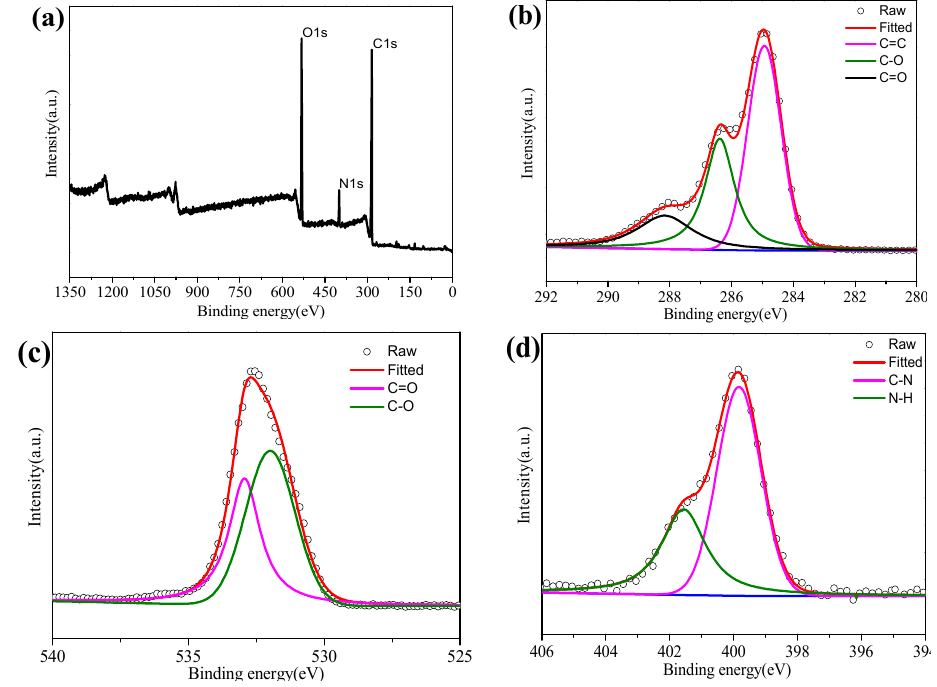
Figure 4. XPS survey scan of N-CQDs on the Si substrate. XPS full scan spectrum ( a ) and XPS high-resolution survey scan of ( b ) C1s, ( c ) N1s, and ( d ) O1s region. The heating time for N-CQDs is 2h.